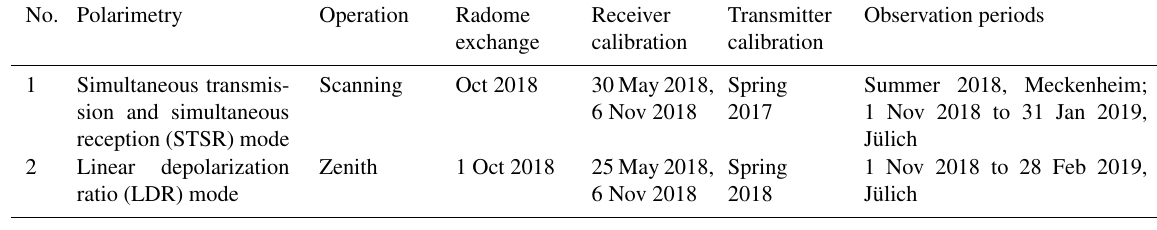
Table 2. Information of type, data periods, and calibration of the radars used for this study.